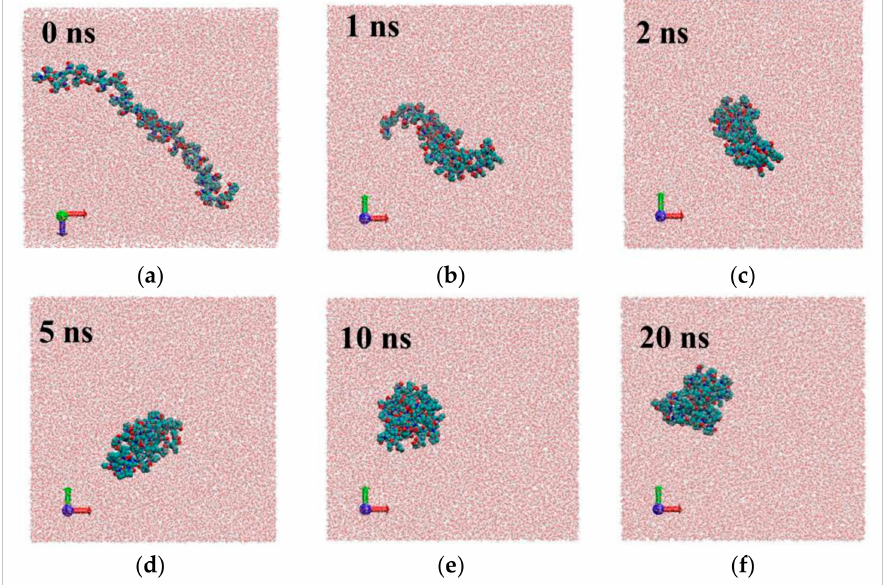
Figure 4. Snap shots of di ff erent frames for system1 with PVP potential based on GROMOS force field parameters [18]: 0 ns ( a ), 1ns ( b ), 2 ns ( c ), 5 ns ( d ), 10 ns ( e ), 20 ns ( f ). Table 2. The average number of hydrogen bonds ( < n HB > ) PVP–water (per PVP molecule and monomer unit), PVP–CEL (per PVP molecule), CEL–water and CEL–CEL (per CEL monomer unit), water–water (per water molecule), the radius of gyration ( R g , nm), the average number of close contacts between any pair of atoms from PVP and CEL within the limits of 0.5 nm ( < N C > ), the average minimum distance between any pair of atoms from PVP and CEL within the bounds of 0.5 nm ( < r min > , nm). < n > HB R g nm < N C System